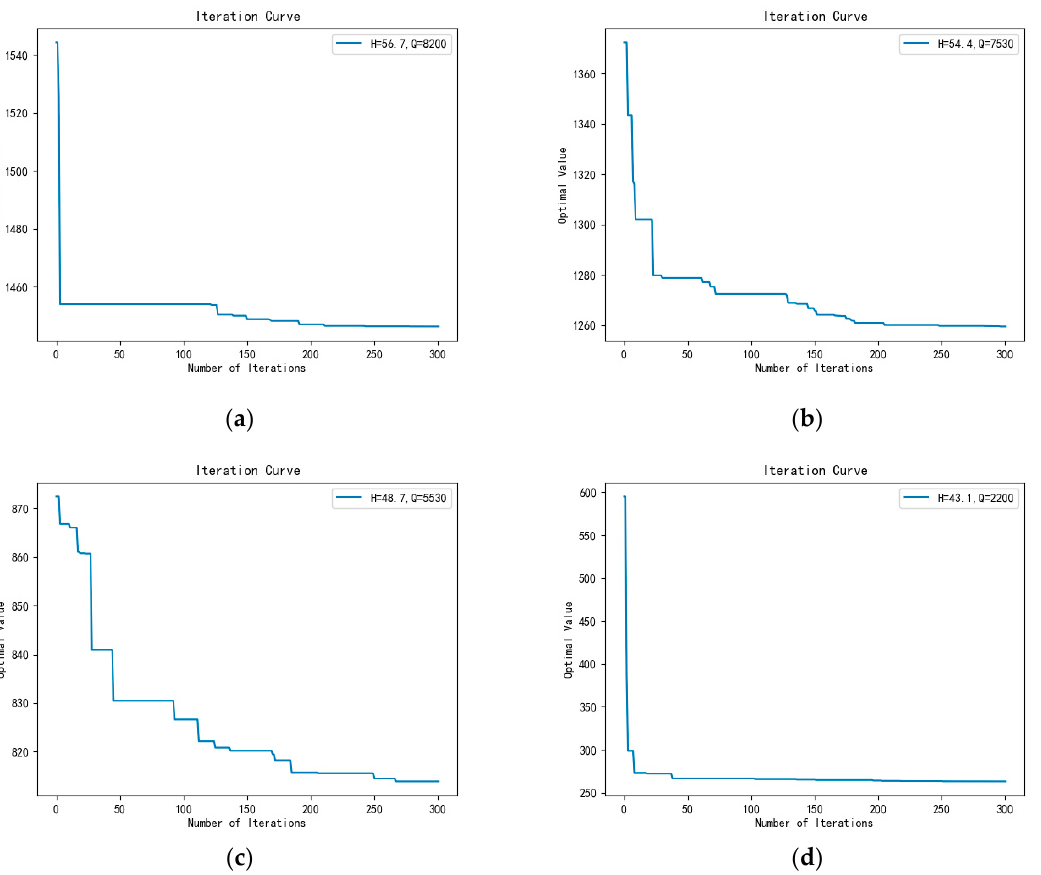
Figure 3. Iterative optimization process for different hydraulic demands. ( a ) Iteration under the condition of H = 56.7 and Q = 8200. ( b ) Iteration under the condition of H = 54.4 and Q = 7530. ( c ) Iteration under the condition of H = 48.7 and Q = 5530. ( d ) Iteration under the condition of H = 43.1 and Q = 2200. Table 1. Part of the results from the improved DE algorithm optimization process.